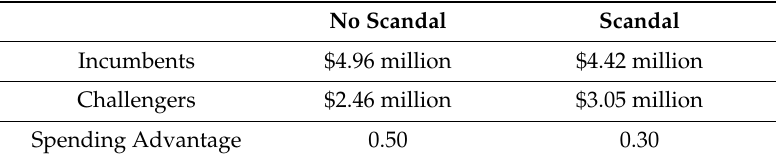
Table 4. Campaign